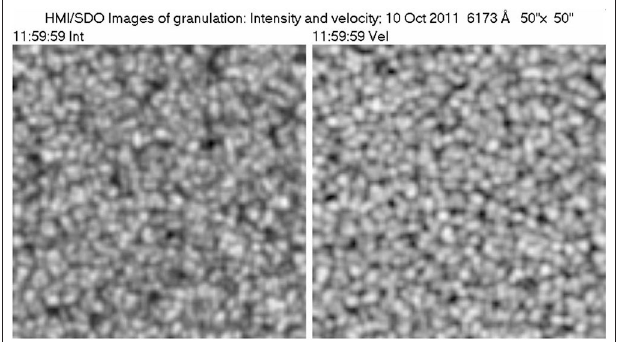
FIGURE 5 | Image of the photospheric granulation at the center of the disk (left), together with an image of the line of sight velocity (white toward the observer). The velocity image has been averaged over 5 min to reduce the effect of oscillations. In this and subsequent figures the field of view is marked in the figure title. Images produced by the author, using data from the Helioseismic and Magnetic Imager (HMI) aboard the Solar Dynamics Observatory